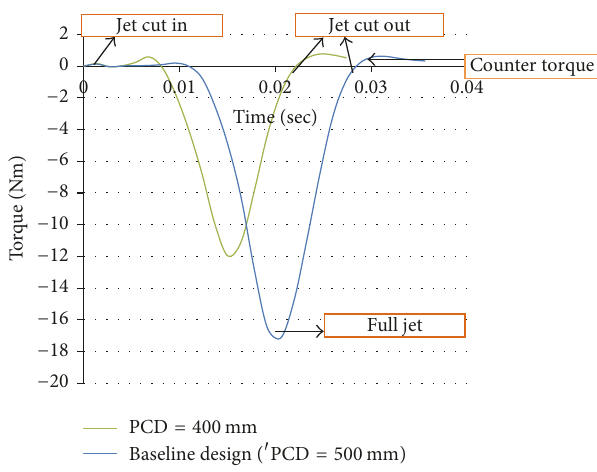
Figure 16: Torque generated by middle bucket versus time.